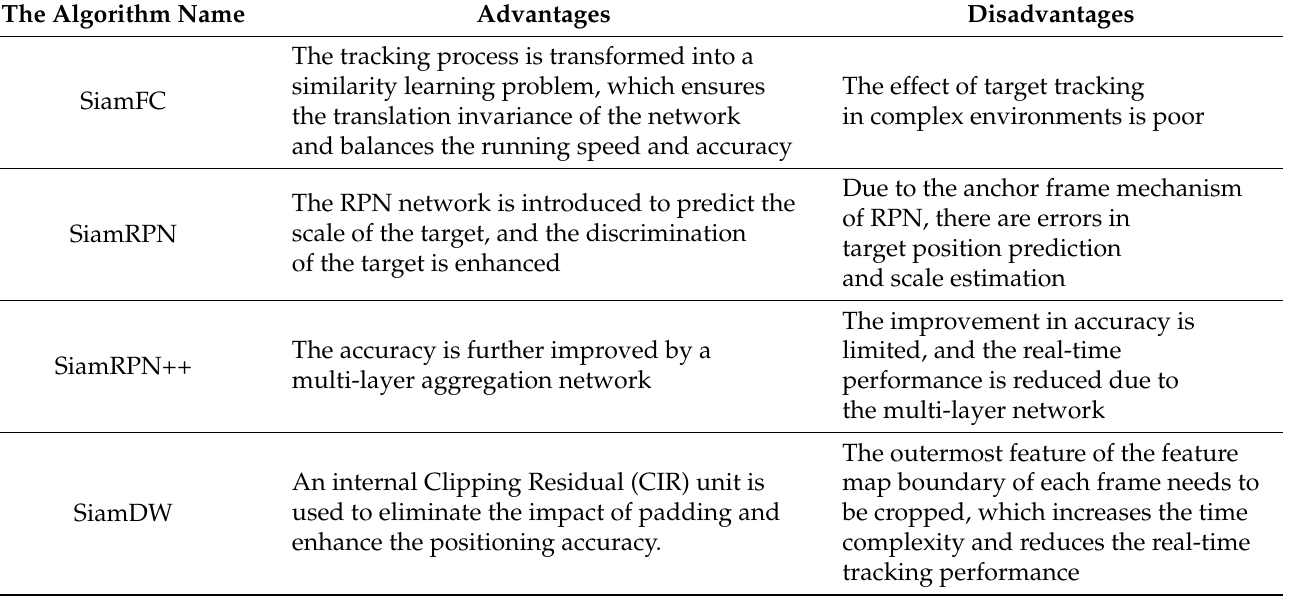
Table 2. Performance comparison of different Siamese network